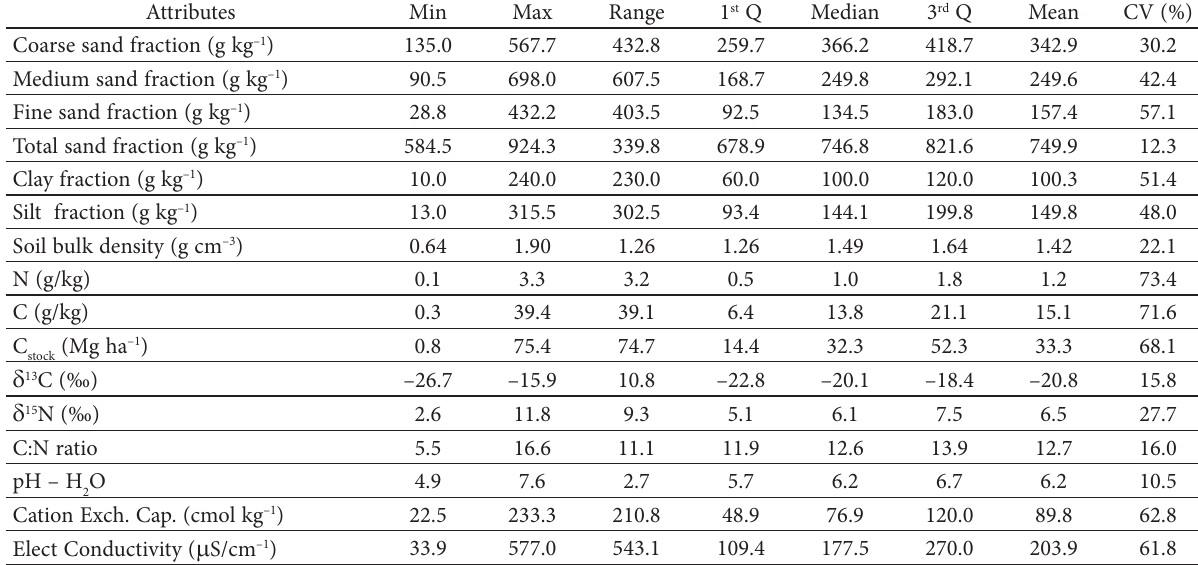
Table 2. Summary statistics for studied attributes considering all samples (N = 40)